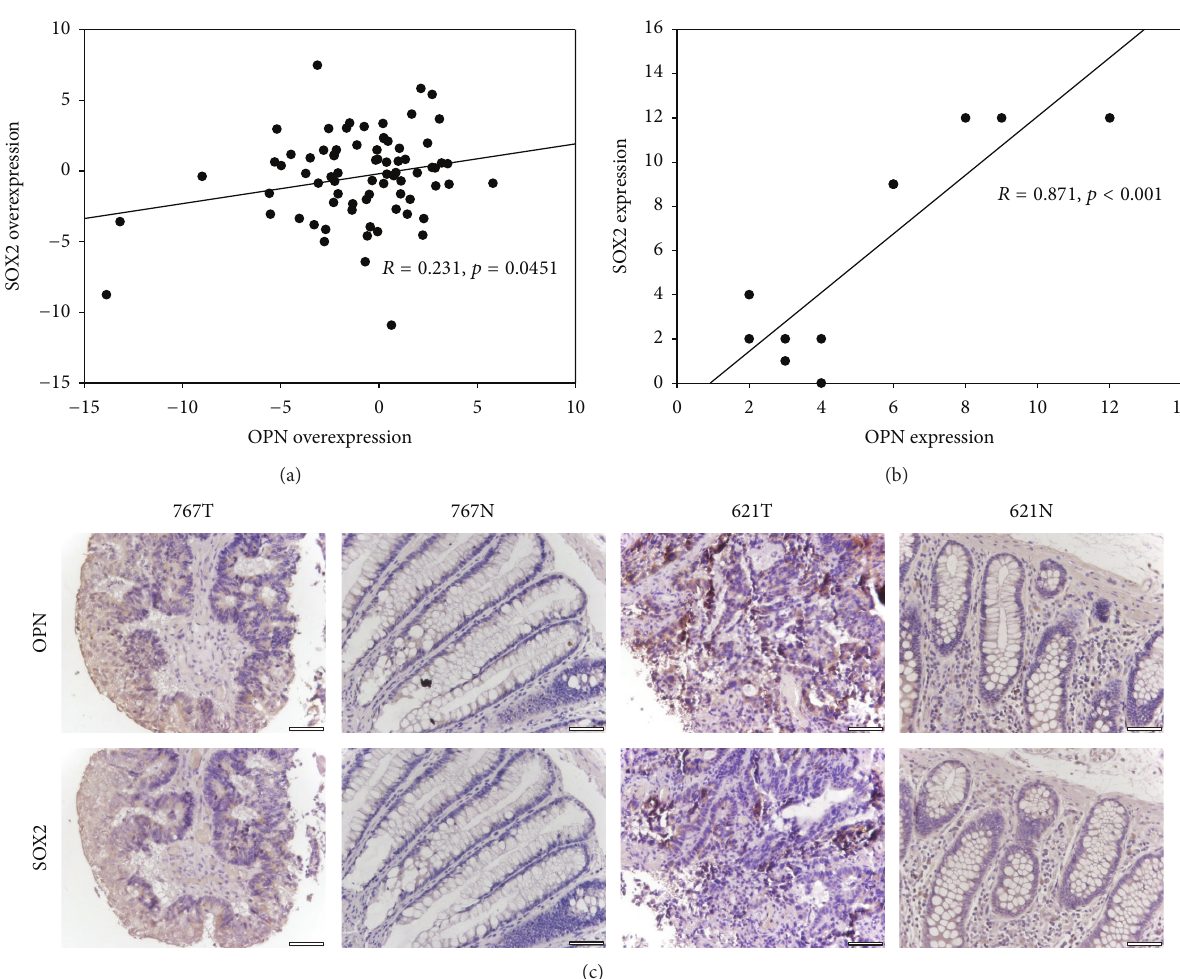
Figure 3: (a) Correlation of OPN mRNA overexpression with SOX2 mRNA overexpression in CRC patients. (b) Correlation of OPN protein expression with SOX2 protein expression in CRC tissues of 11 patients. (c) Representative images showing correlation of OPN and SOX2 protein expression in CRC tissues (621T: OPN high/SOX2 high; 767T: OPN low/SOX2 low). Negative/weak staining of OPN and SOX2 were detected in most adjacent normal tissues